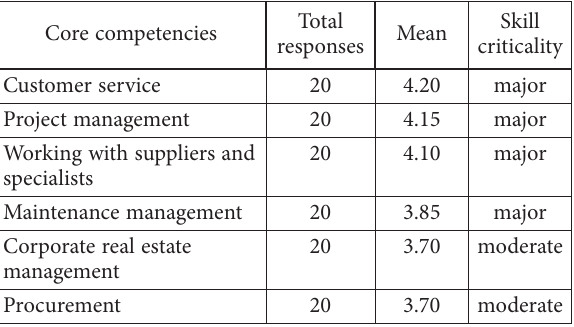
Table 5. Respondents’ raking of core competencies Core competencies